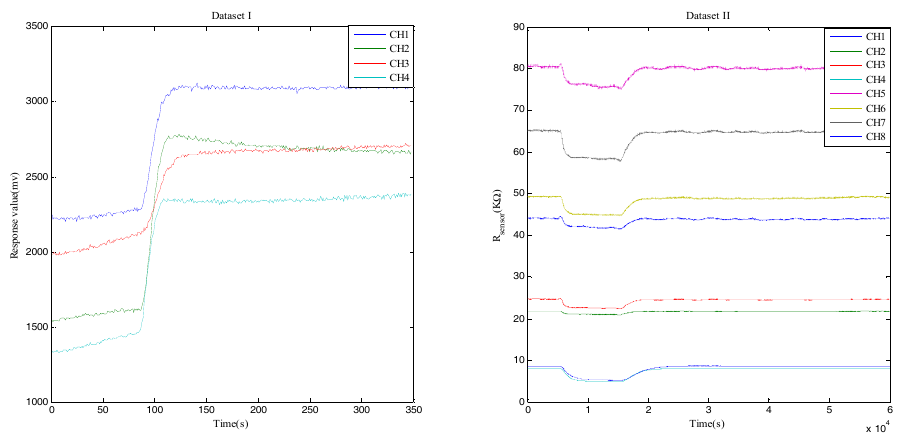
Figure 1. Response curves of the sensors in the two experiments. Dataset I has four channels (CH1–CH4), while Dataset II has eight channels (CH1–CH8).